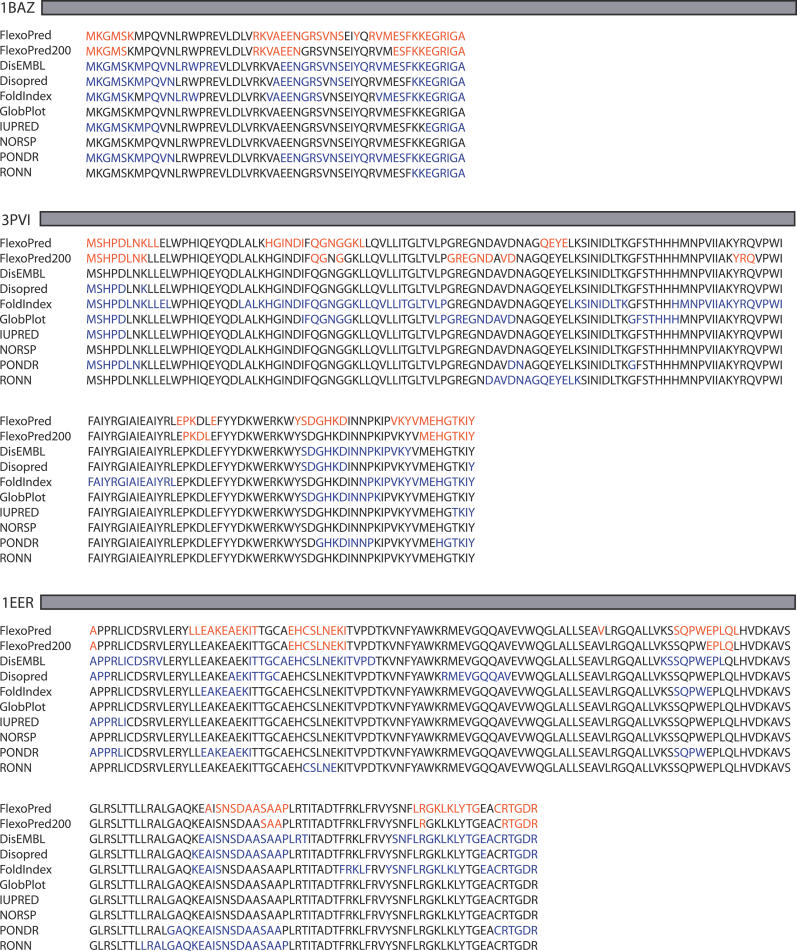
Comparison of Wiggle Predictors to Structural Disorder PredictorsComparison of prediction results from Wiggle (red) to various disorder predictors (blue).